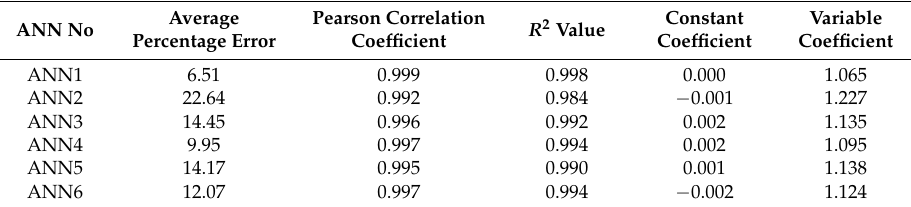
Table 8. Testing error analysis of each ANNs.